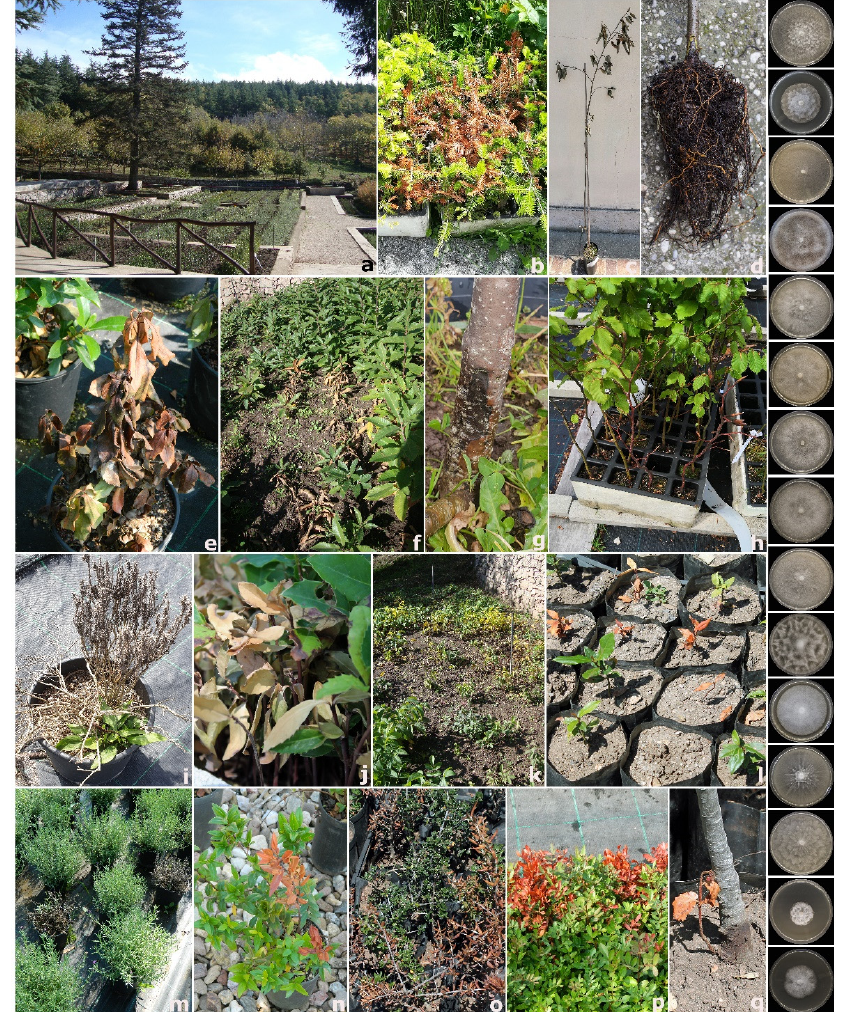
Figure 1. Overview of the forest nursery N1 ( a ), symptoms of wilting, sudden death and collar and root rot observed on: Abies alba ( b ), Alnus incana ( c , d ), Arbutus unedo ( e ), Castanea sativa ( f , g ), Fagus sylvatica ( h ), Helichrysum italicum ( i ), Ilex aquifolium ( j ), Juglans regia (k), Laurus nobilis ( l ), Lavandula officinalis ( m ), Myrtus communis ( n ), Phyllirea latifolia ( o ), Pistacia lentiscus ( p ) and Quercus ilex ( q ) seedlings. On the right from the top, colony morphology of: Phytophthora acerina , P. bilorbang , P. cactorum , P. cinnamomi , P. citrophthora , P. mediterranea , P. megasperma , P. nicotianae , P. palmivora , P. parvispora , P. pistaciae , P. plurivora , P. pseudocryptogea , P. pseudosyringae and P. psychrophila after 7 days growth at 25 °C on CA in the dark.